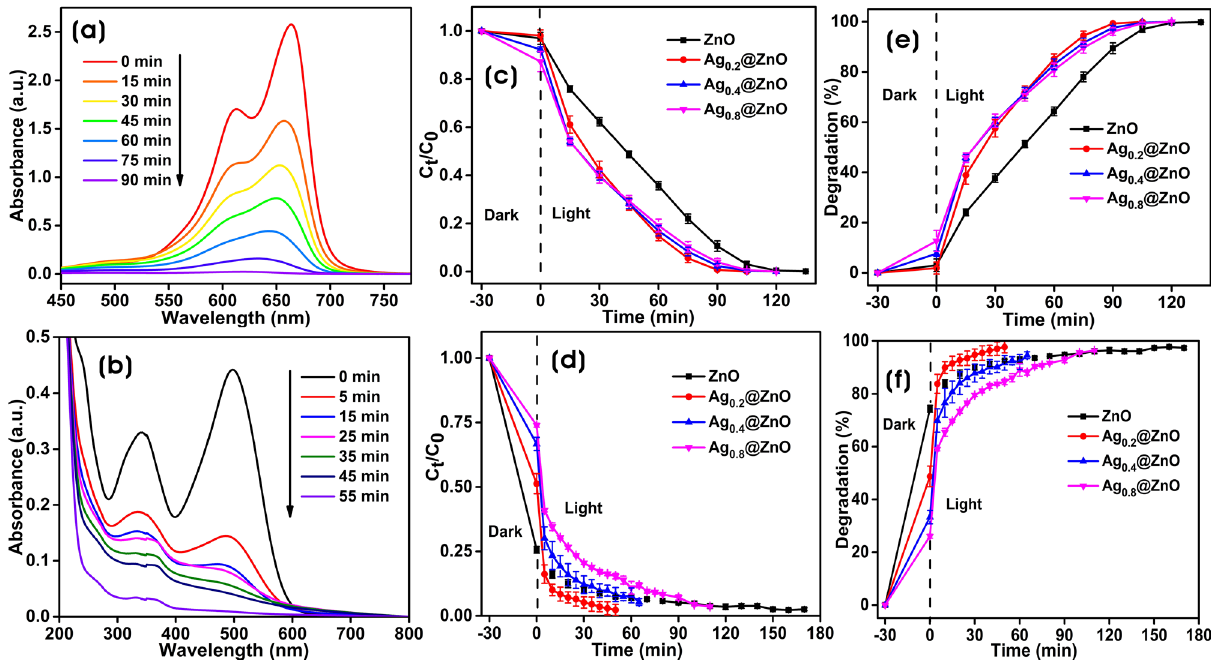
Figure 11. UV–Vis absorbance spectra of the photocatalytic degradation of MB ( a ) and CR ( b ). The plot of C t /C 0 against time in the degradation of MB ( c ) and CR ( d ). The degradation percentage of MB ( e ) and CR ( f ) against time by Ag 0.2 @ZnO